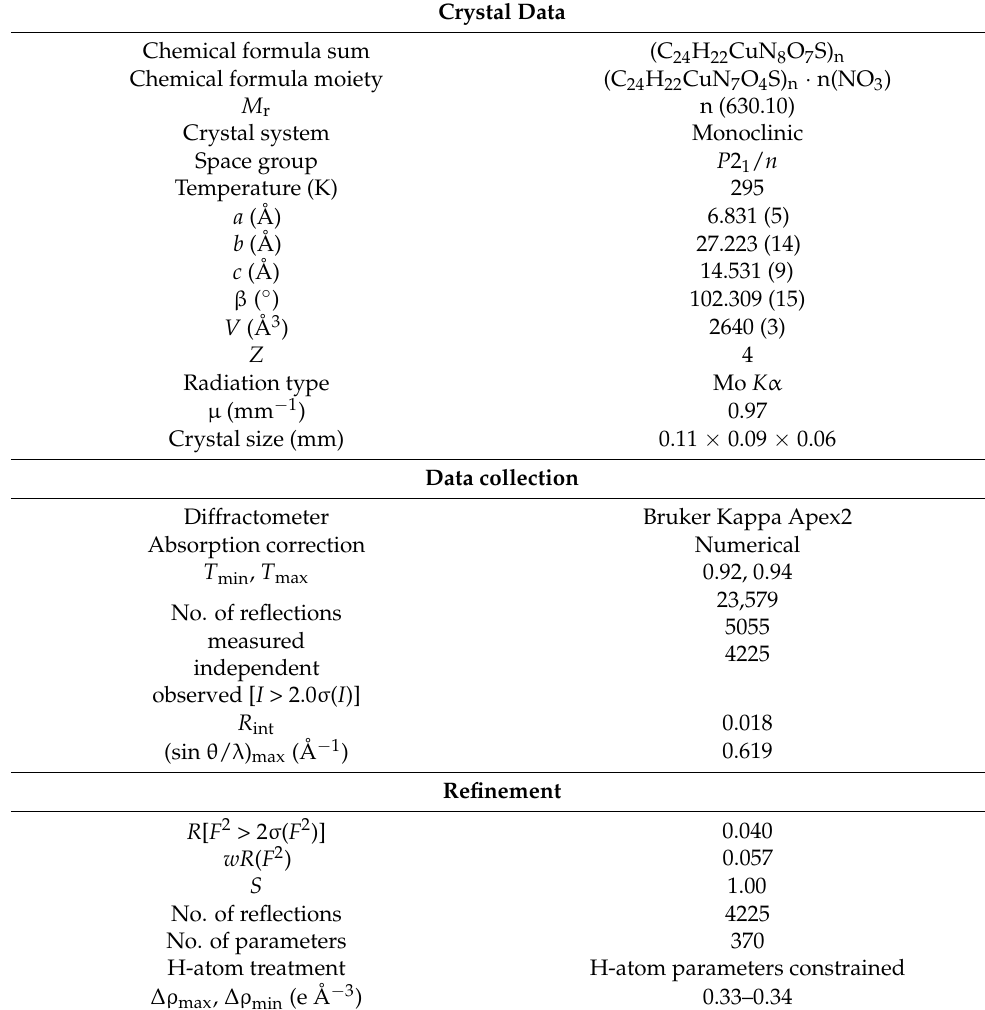
Table 1. Summaryofcrystal, intensitycollectionandrefinementdatafor[Cu(C 21 H 18 N 4 OS)(C 3 H 4 N 2 )(NO 3 )]n · n(NO 3 ) ( Cu-1 ).